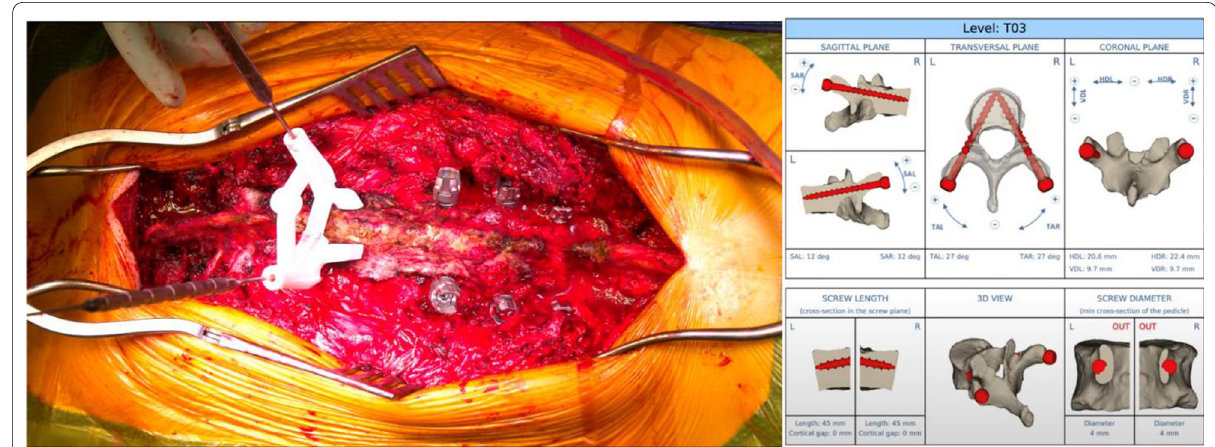
Fig. 2 Patient-specific guides were used for pedicle screw placement because of the abnormal anatomy of posterior elements due to prior